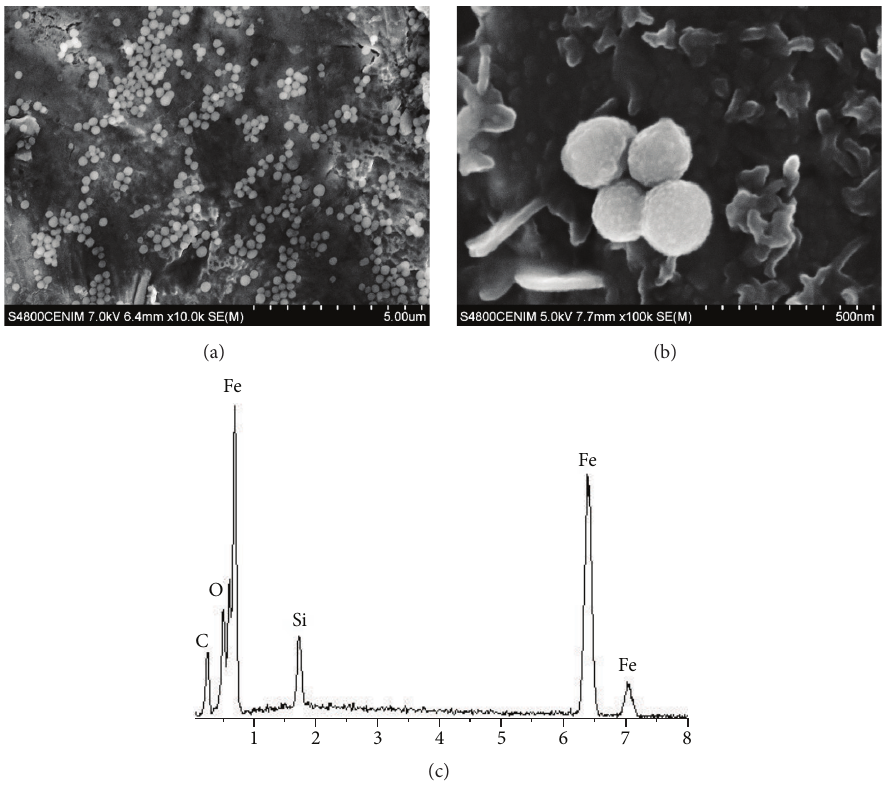
Figure 1: SEM images at two different magnifications (a) and (b) and EDX analysis (c) of the synthetized SiO 2 mesoporous nanoparticles.